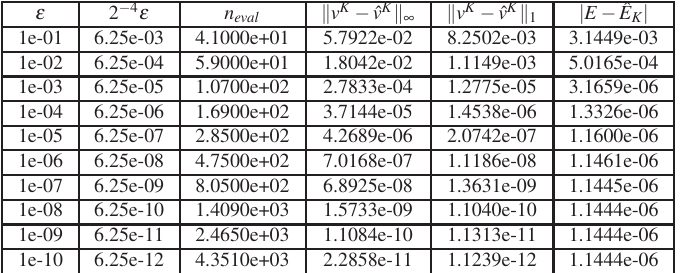
Table 13 Parameters as specified in Table 1 for f 2 , K = 15 and the PCHIP rule. ε k = ε varies between 10 − 1 and 10 − 10